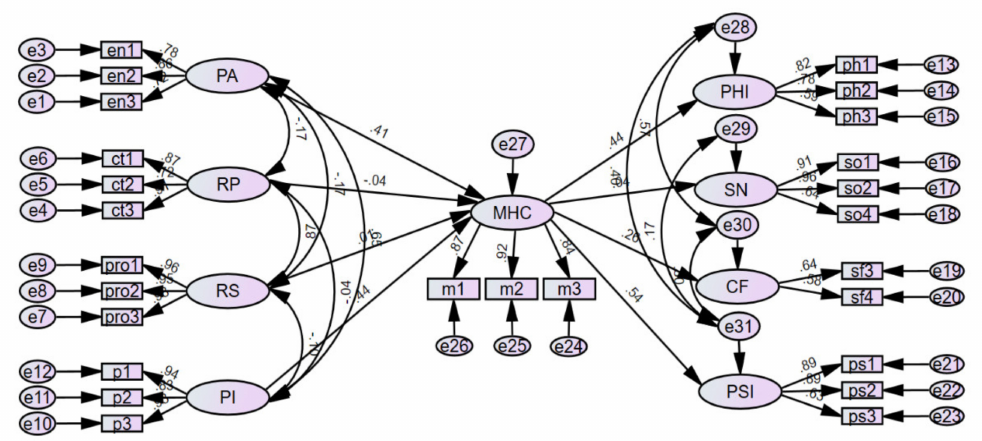
Figure 2. Standardized regression weights of the final research model. PA: program atmosphere; RP: relationships with patients; RS: relationships with staff; PI: program involvement; MHC: integration into the mental health community; PHI: physical integration; SN: social network size; CF: social contact frequency; PSI: psychological integration. Table 4. Goodness of fit of the final research